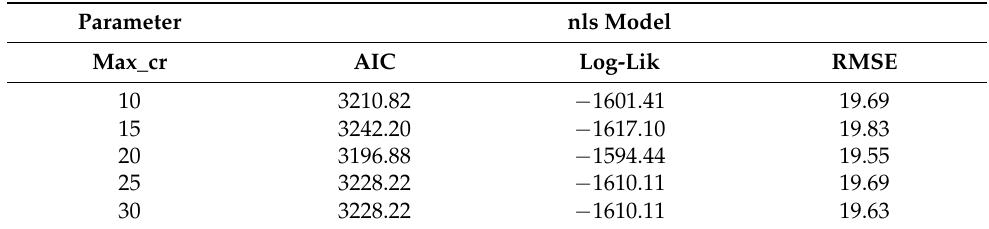
Table 2. AIC, log-likelihood, and RMSE values according to the nls model (AIC: Akaike’s information criterion, Log-Lik: log-likelihood, RMSE: root-mean-squared error). Table 2. AIC, log ‐ likelihood, and RMSE values according to the nls model (AIC: Akaike’s infor ‐ mation criterion, Log ‐ Lik: log ‐ likelihood, RMSE: root ‐ mean ‐ squared error).